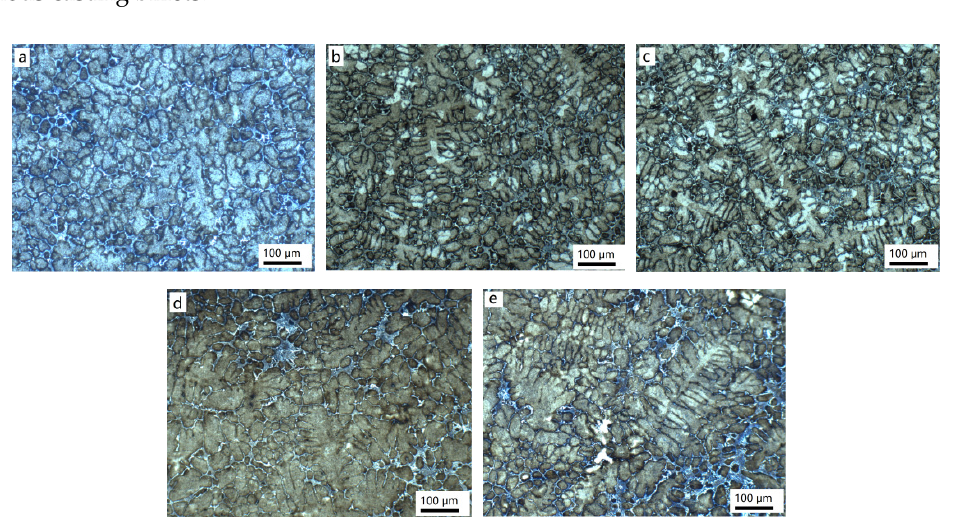
Figure 2. Microstructure (×100) of the different samples from the M2 steel billet cast in the sand mold ( a – e for the billet from edge to center).